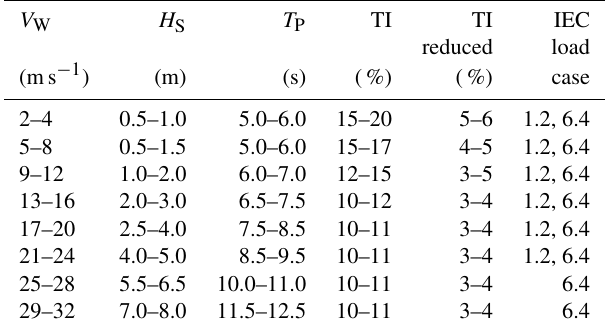
Table 1. Load case combinations presented in groups consisting of mean wind speed V W , significant wave height H S , wave peak period T P , turbulence intensity TI , and IEC load case. Each group contains 100–300 simulations of 10min